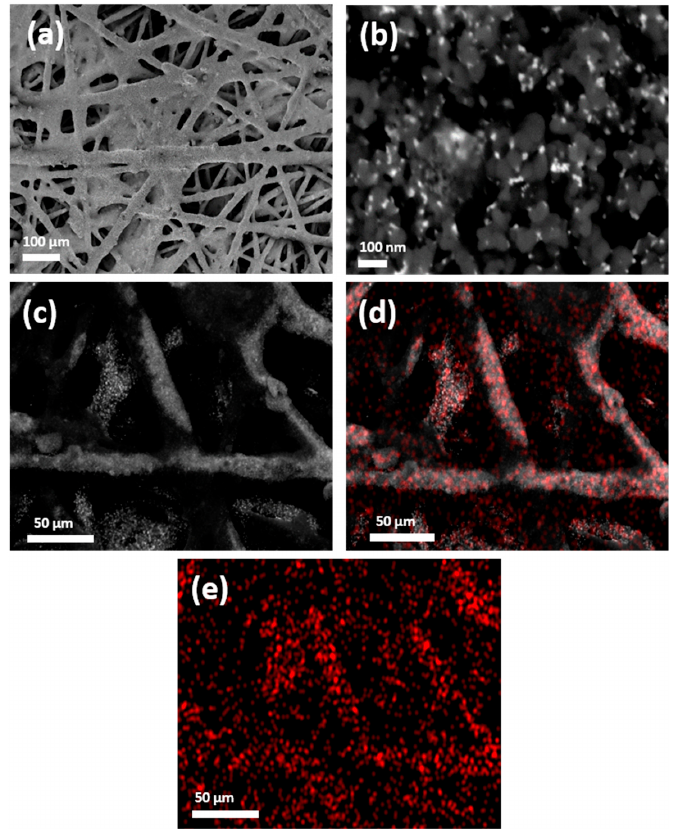
Figure 2. Field emission SEM images of the Bi/C electrode with Bi loading of 0.1 mg cm − 2 : ( a ) magnification ×130, and ( b ) magnification ×100.00 K. Micrographs ( c – e ) correspond to SEM-EDX mapping: d and e highlight, in red, the distribution of BiNPs on the carbon substrate.